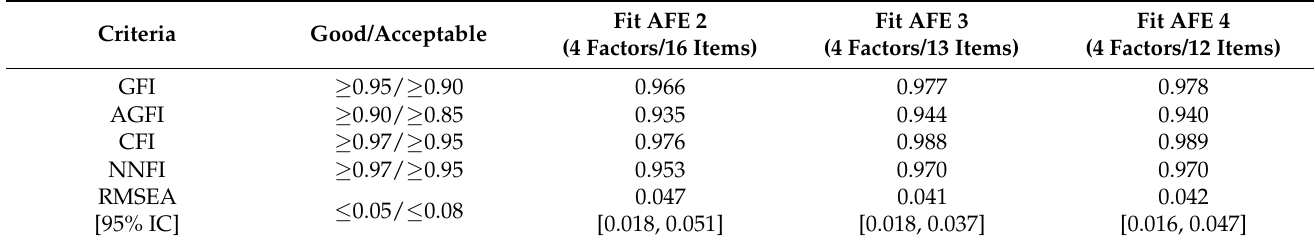
Table 1. Comparison of CPHQ models with 4 factors. Fit indices.